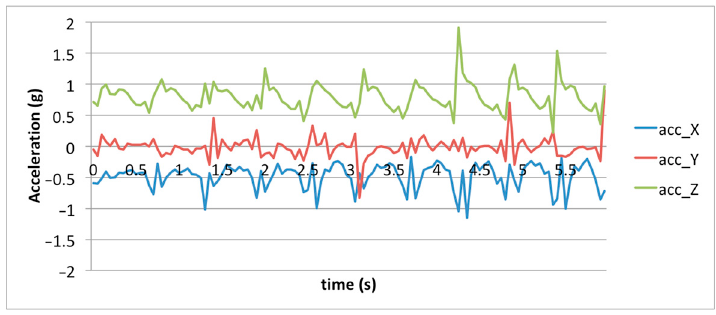
Figure 6. Accelerometer data acquired during healthy gait.